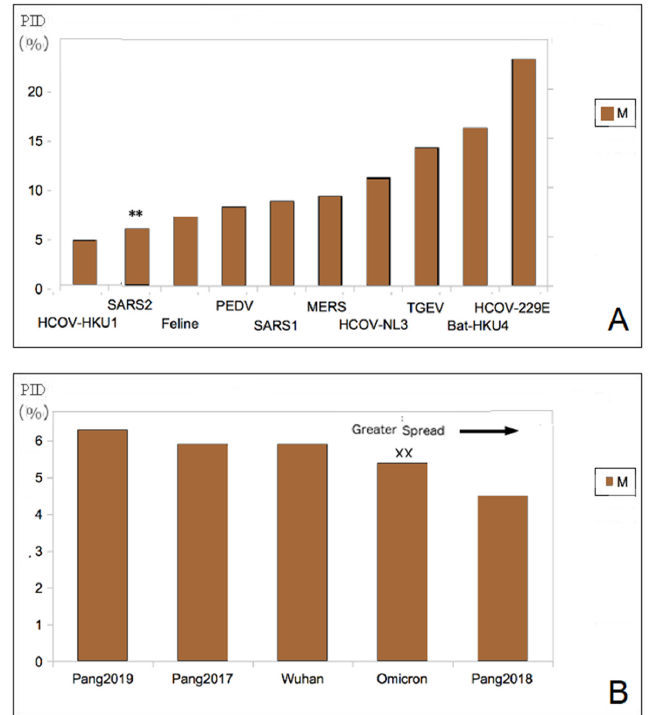
Figure 1. ( A ). All CoVs are closely related to SARS-CoV-2 (**). SARS-CoV-2 has the lowest M-PID (hardest outer shell) among all the CoVs analyzed in this study. ( B ). A hard outer shell is seen among COVID-related CoVs. Omicron (XX) has the lowest among all SARS-CoV-2 variants. We will notice that, in Figure 1B, only HCoV-HKU1 has a harder M (M PID: 4,7%) than SARS-CoV-2. HCoV-HKU1 that was first disordered in a 71-year-old patient in 2004,